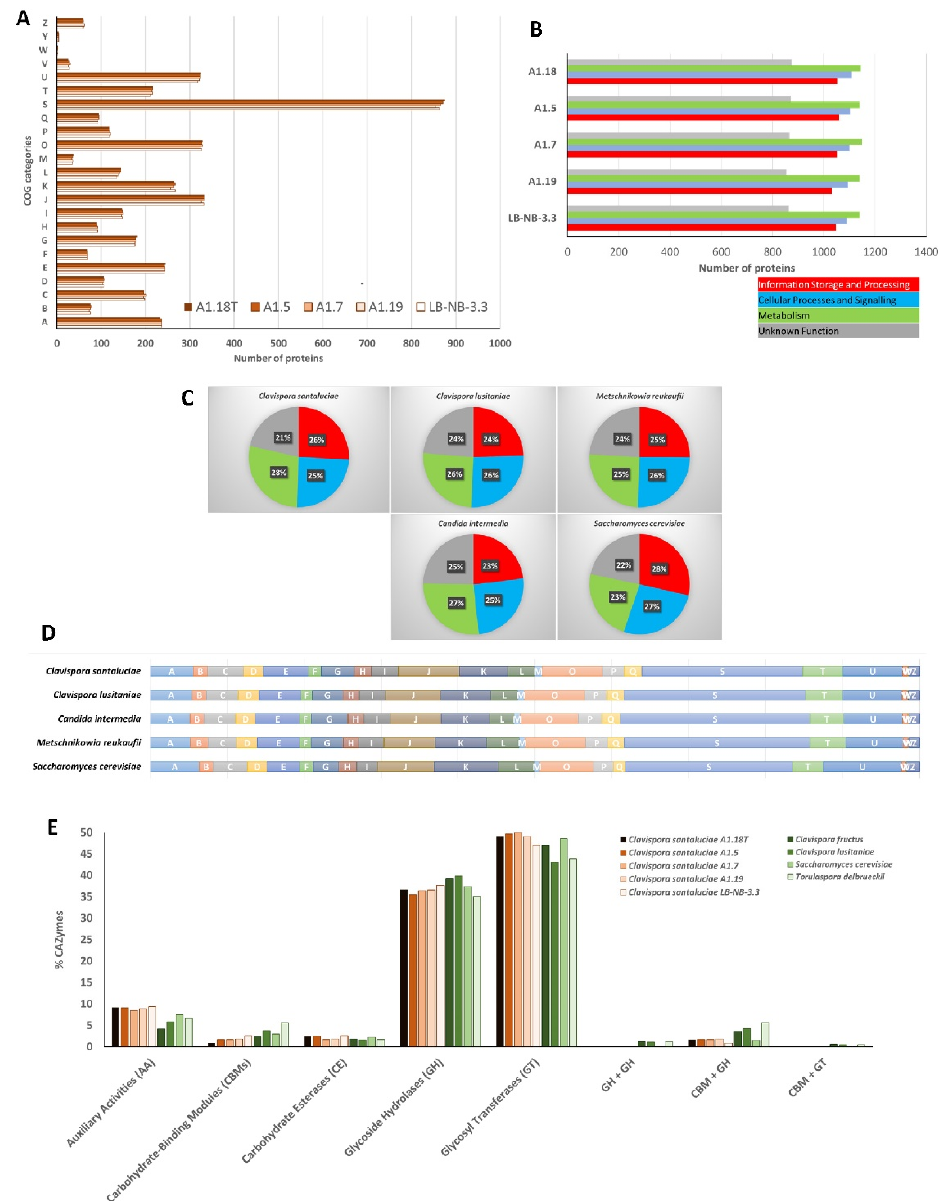
Figure 2. Functional annotation of Clavispora santaluciae genome: ( A ) proteome classification into 23 functional categories, corresponding to clusters of orthologous groups (COGs): A, RNA processing and modification; B, chromatin structure and dynamics; C, energy production and conversion; D, cell cycle control and mitosis; E, amino acid metabolism and transport; F, nucleotide metabolism and transport; G, carbohydrate metabolism and transport; H, coenzyme metabolism; I, lipid metabolism; J, translation; K, transcription; L, replication and repair; M, cell wall/membrane/envelop biogenesis; O, posttranslational modification, protein turnover, chaperone functions; P, inorganic ion transport and metabolism; Q, secondary Structure; S, function unknown; T, signal transduction; U, intracellular trafficking and secretion; Y, nuclear structure; Z, cytoskeleton; ( B ) classification of the annotated genes into four large functional categories; ( C ) comparison between the five Clavispora santaluciae strains and other relevant yeast species in proportions of the large functional categories; ( D ) comparison between relevant yeast species classification of the annotated genes into 23 COG categories; ( E ) percentage of CAZymes in the five sequenced genomes of Clavispora santaluciae and other relevant yeasts, showing the distribution of predicted proteins into major families.